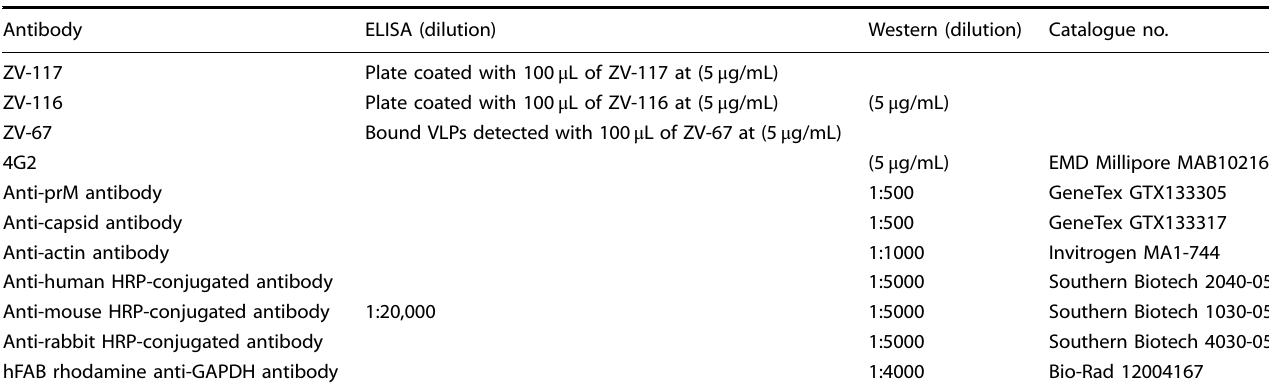
Table 1. Antibody